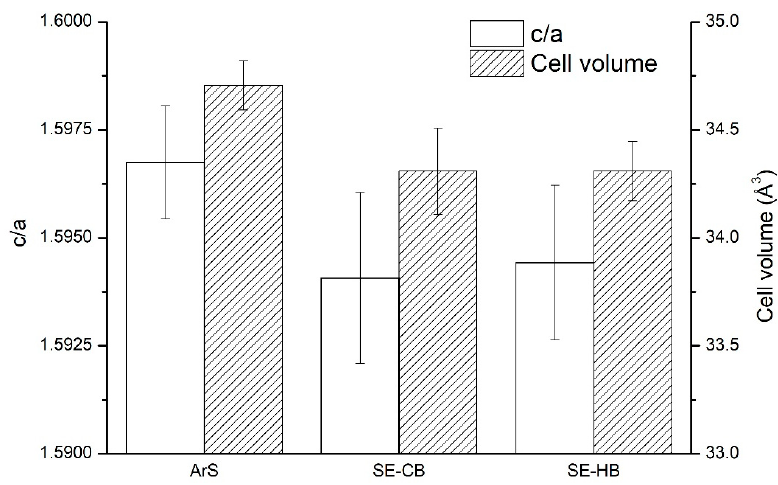
Figure 4. c / a ratio and cell volume for all the conditions Figure 4. c/a ratio and cell volume for all the conditions considered.